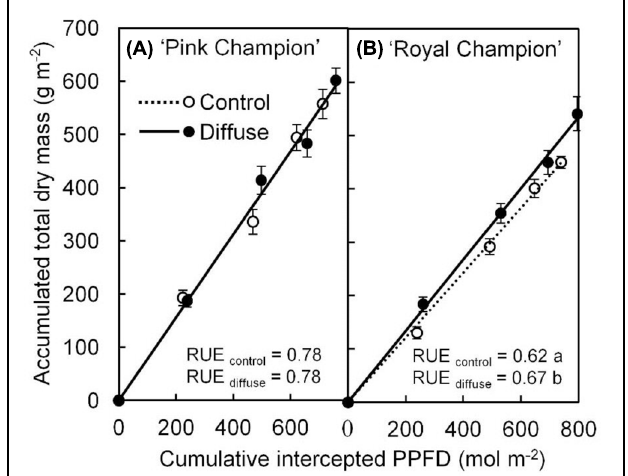
FIGURE 1 | Relationship between accumulated TDM and cumulative intercepted PPFD for ‘Pink Champion’ (A) and ‘Royal Champion’ (B) in the control and diffuse light treatments. Solid and dashed lines represent fitted linear relationships for diffuse light and control treatments, respectively. The slope of the fitted linear relationship is the RUE of biomass production (g dry mass mol − 1 PPFD). Dashed line in ‘Pink Champion’ is obscured by the solid line. Error bars show ± SE ( n = 12). Letters show statistical significant differences ( P <